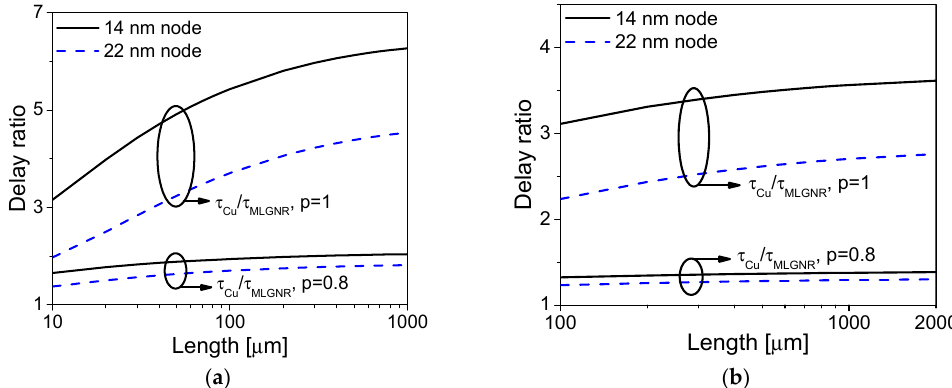
Figure 4. ( a ) Multi-conductor transmission line model and ( b ) equivalent single-conductor (ESC) transmission line model of side-contacted MLGNR interconnect [38].